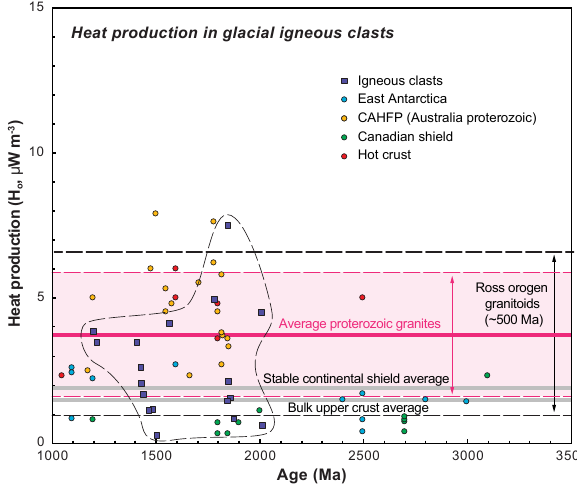
Figure 4. Plot of surface heat production ( H o ) vs. age for ig- neous glacial clasts. Data are listed in Table 1. Range of heat production values in Ross orogen granites from unpublished data. For comparison, values are shown from East Antarctica (Carson and Pittard, 2012; Carson et al., 2014), the Central Australian Heat Flow Province (CAHFP; McLaren et al., 2003), the Canadian Shield (Mareschal and Jaupart, 2013; Jaupart et al., 2016), and ar- eas of high heat production in stable continental provinces (“hot crust”; Mareschal and Jaupart, 2013; Jaupart et al., 2016). Average heat production in Middle and Late Proterozoic granites of about 3.8µWm − 3 are from Artemieva et al. (2017). Bulk upper crustal average of about 1.6µWm − 3 from Kemp and Hawkesworth